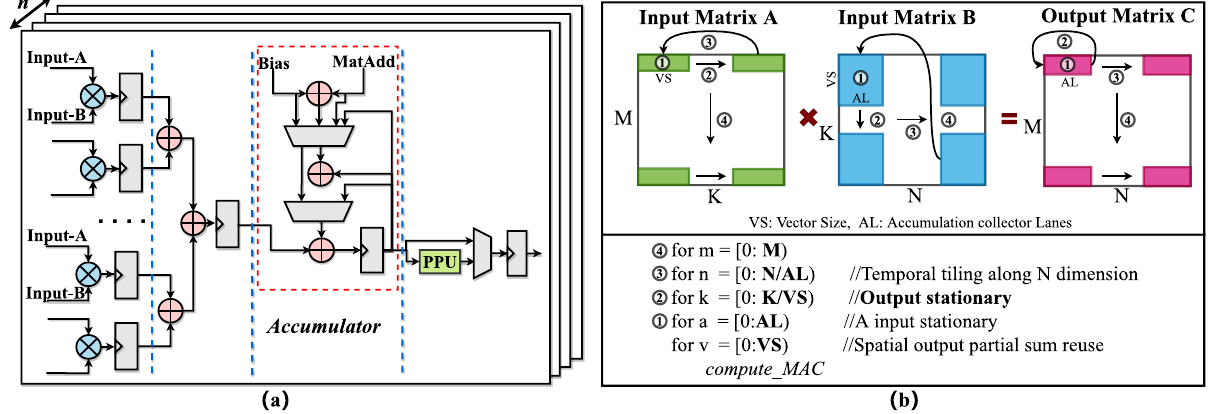
Figure 3. ( a ) The block diagram of an engine in the MCA. ( b ) Workload mapping and data reuse.